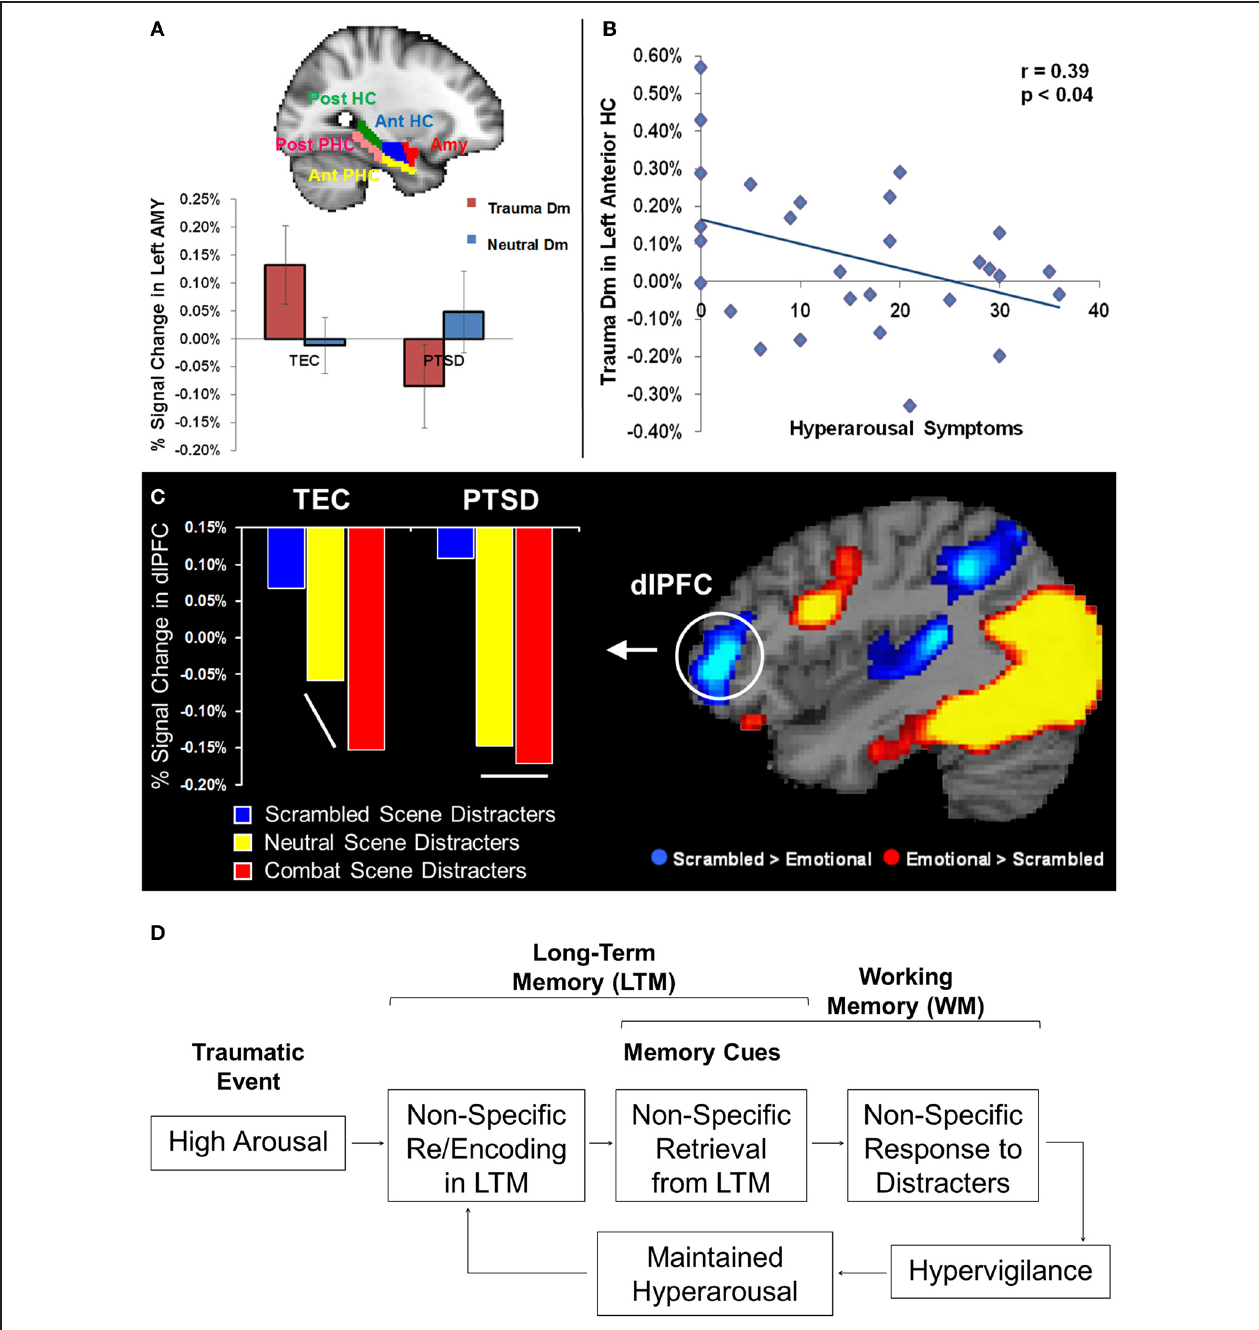
FIGURE 1 | (A–B) Memory-Related Changes in the Medial Temporal Lobe Activity in PTSD. Reduced memory-related activity (Dm) in AMY for trauma-related pictures, in the PTSD group (A) ; a similar effect was also observed in the HC (not shown). Reduced Dm for trauma-related pictures in the anterior HC linked to increased symptoms of arousal (B) . Dm, Difference due to Memory effect (brain activity for Remembered minus Forgotten items); PTSD, post-traumatic stress disorder; TEC, Trauma-Exposed Control group; AMY, Amygdala; HC, Hippocampus; PHC, Parahippocampal Cortex; Ant, Anterior; Post, Posterior. Error bars represent the standard error of means. Adapted from Hayes et al. (2011), with permission. (C) Evidence for Non-specific Response in dlPFC to